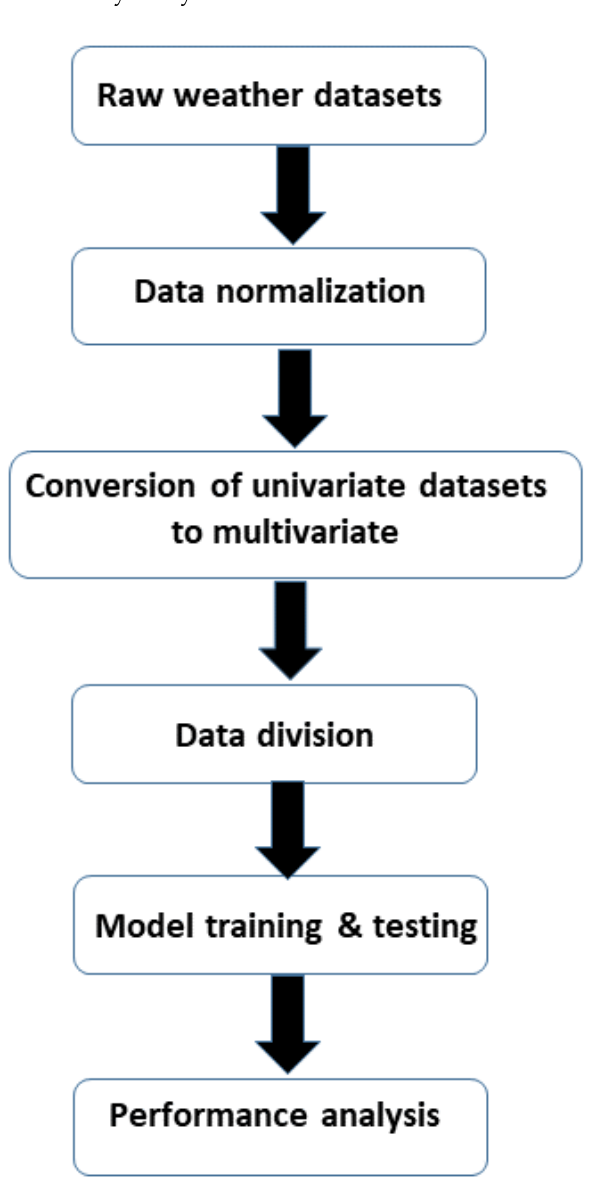
Figure 2. Framework of the proposed data-driven long-term weather forecasting models. Figures 3 and 4 demonstrate the three-hourly time-series data points of wind speeds and wave heights from 1992 to 2016 (10 years) representing high variability. For the sake of simplicity, time series plotted for sample datasets are shown in Figures 5 and 6, respectively. Furthermore, by looking at these two parameters closely, we found that they are closely correlated to each other, which is expected. This is further confirmed by the wave height and wind speed scatter plot as shown in Figure